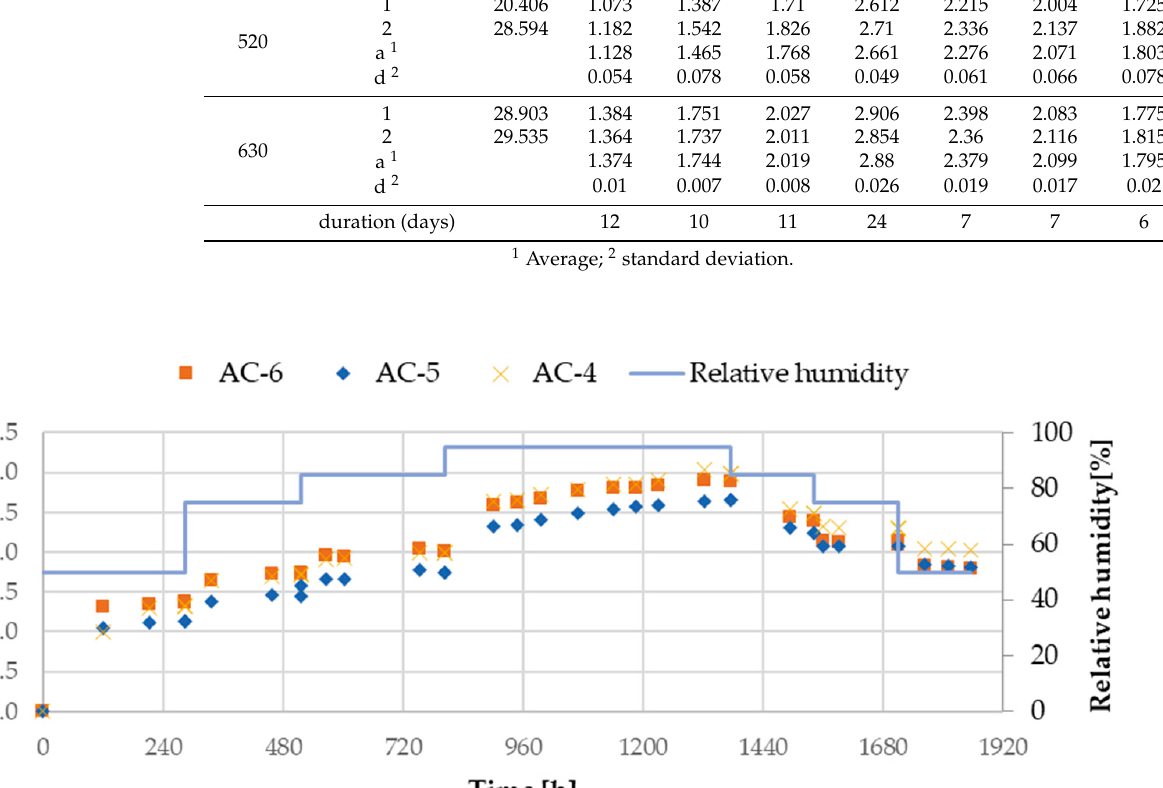
Figure 6. Moisture content of the samples in the environmental chambers. 3.3. Dynamic Vapour Sorption Measurements The result obtained by the DVS device is shown in Table 9, including the total dura- tion of the individual measurements for the sorption and desorption cycle. An example of the time course of the sorption measurement using the DVS device is shown in Figure 7. Figure 7. Sorption kinetic of the AC-4 sample at the first and second cycle.